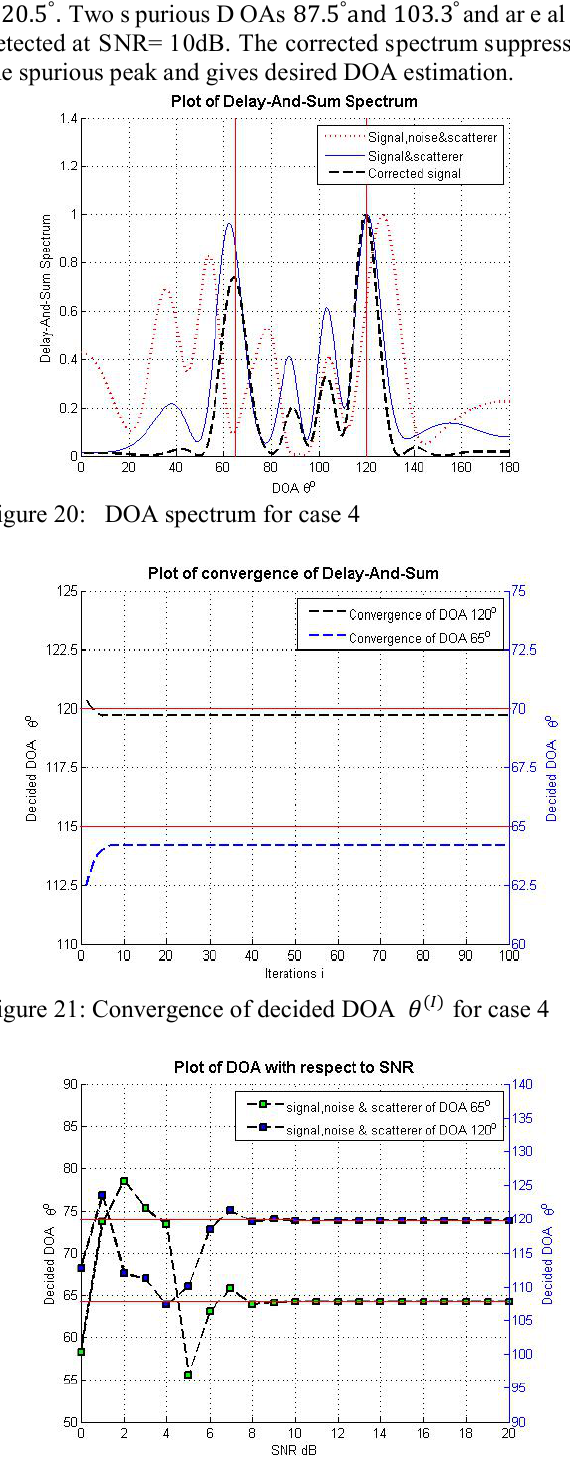
Figure 22: Plot of DOA with respect to SNR for case